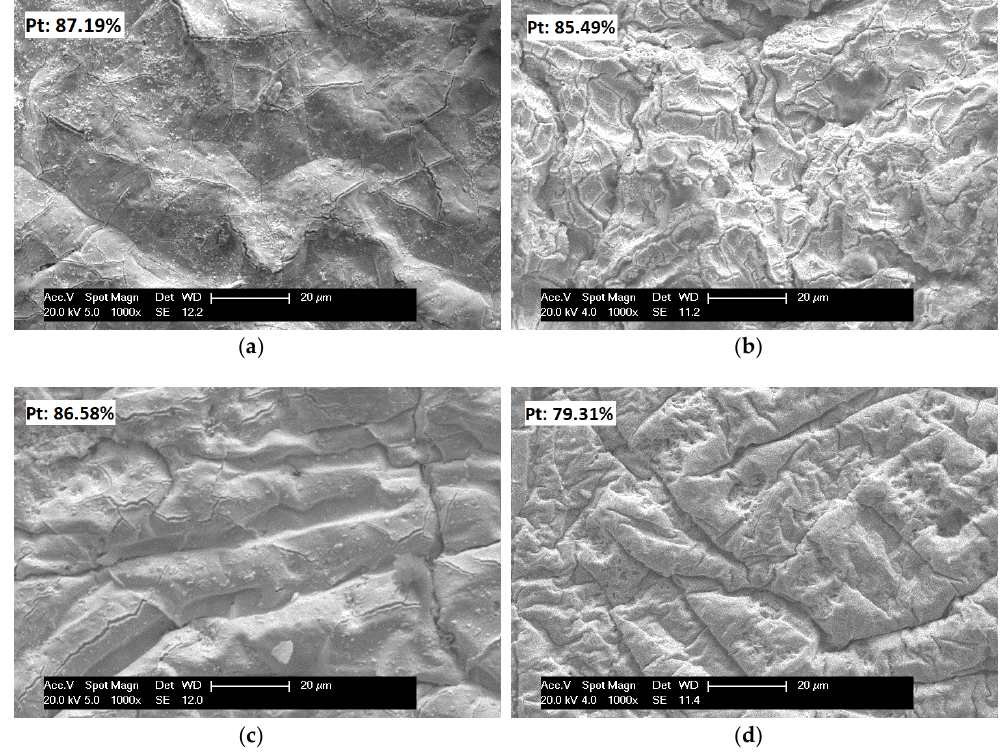
Figure 2. Surface morphology of the IPMCs with various thicknesses. ( a ) 1-film; ( b ) 2-film; ( c ) 4-film; ( d ) 6-film.